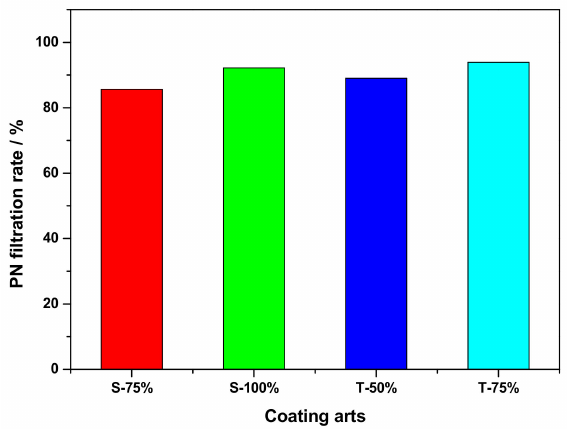
Figure 9. Influence of catalyst coatings on PN filtration e ffi